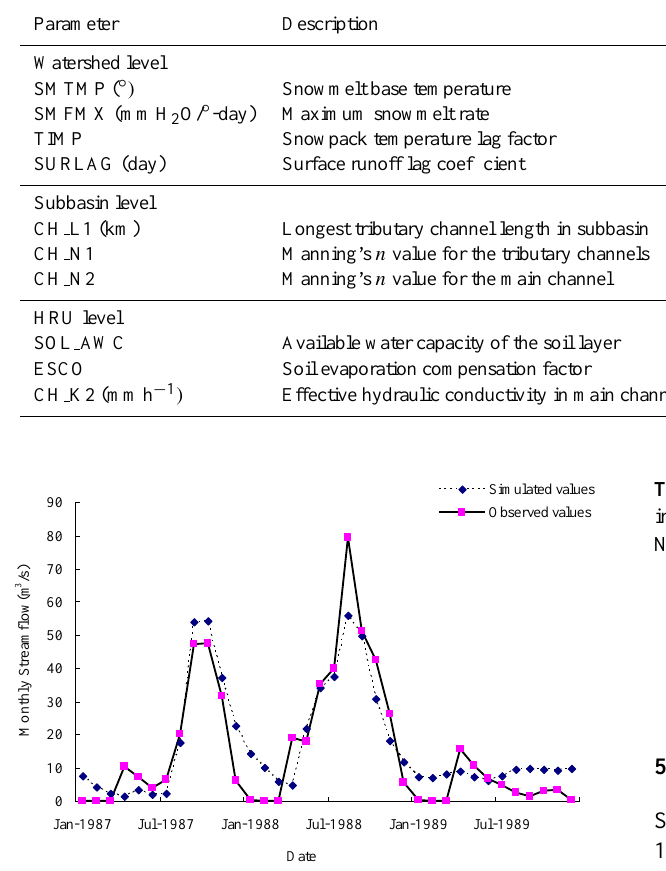
Fig. 5. Comparison between simulated and observed monthly outflow (Binzhouxian station) during the calibration period in the Zhalong Wetland, Northeast China.